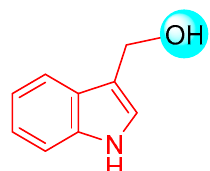
Figure 2. Chemical structure of I3C.